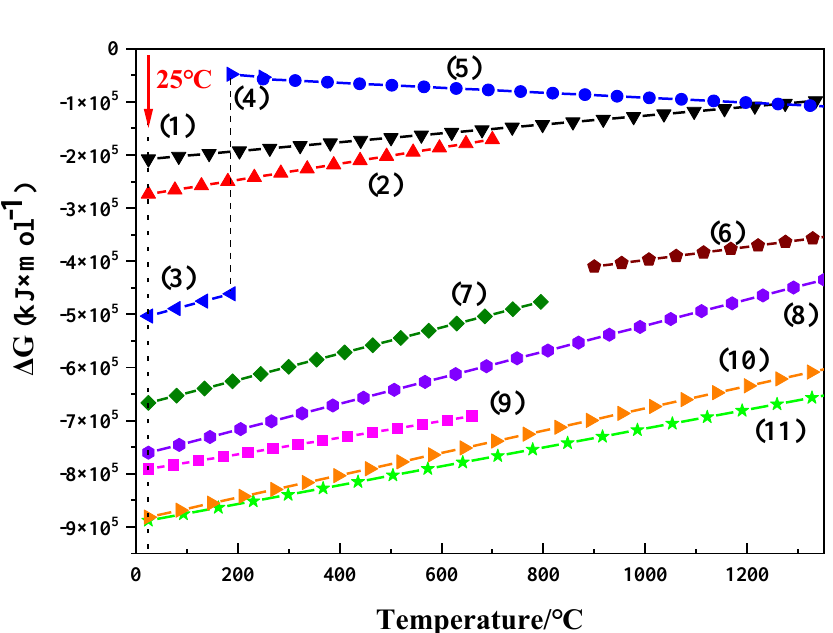
Figure 2. Relationship between Gibbs free energy-temperature for possible oxidation reactions in superalloy.